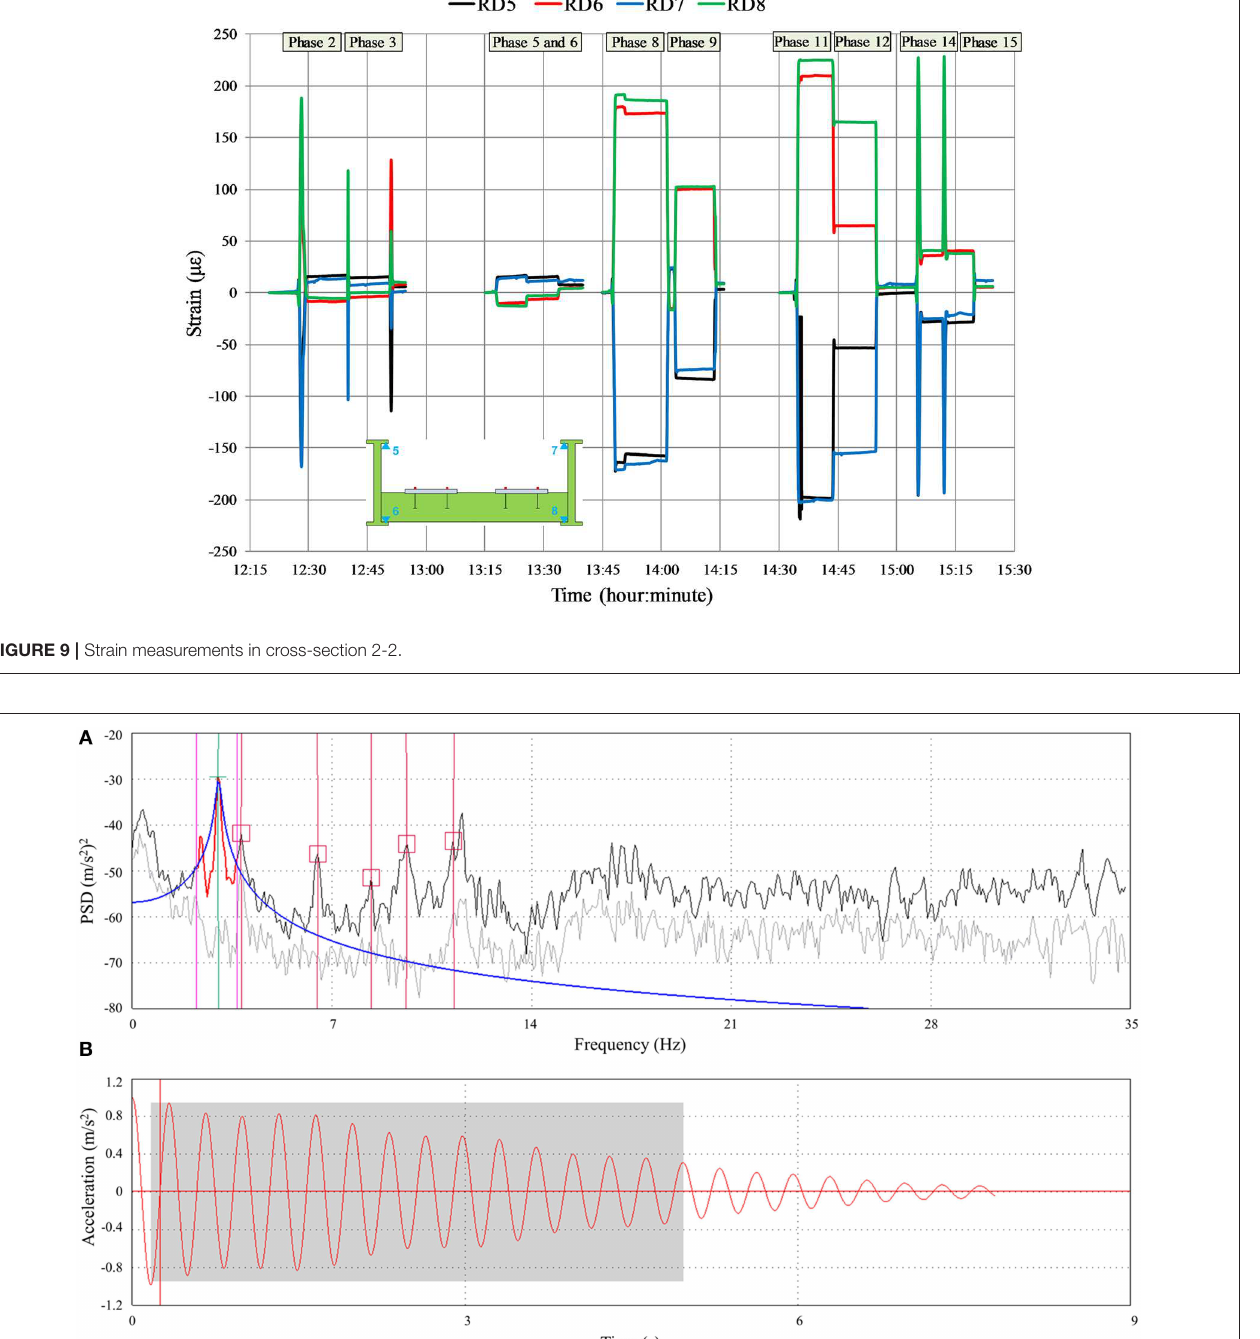
of natural frequencies as well as the measured damping ratios are given in Table 2 , six modes were determined